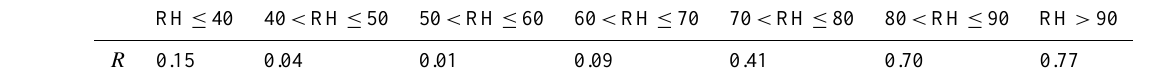
Table 3. Correlation coefficients ( R ) between the MLH and visibility according to RH (%).